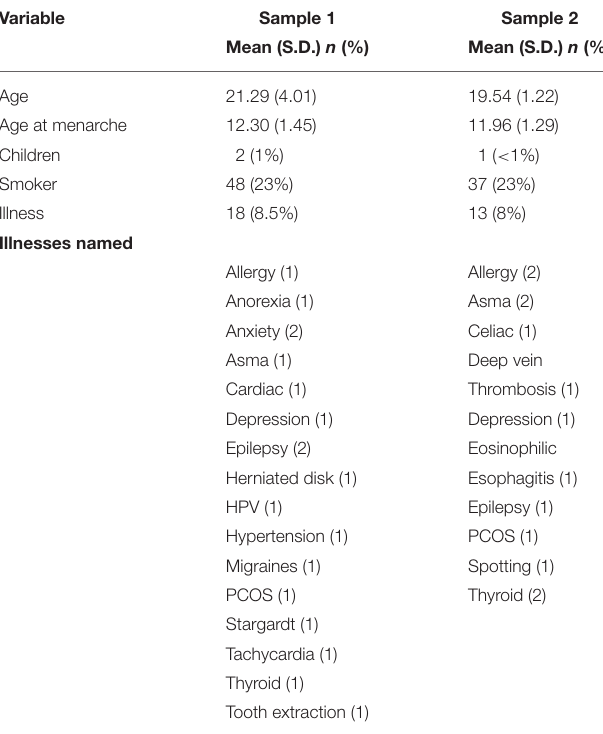
TABLE 1 | Descriptive and demographic characteristics of both